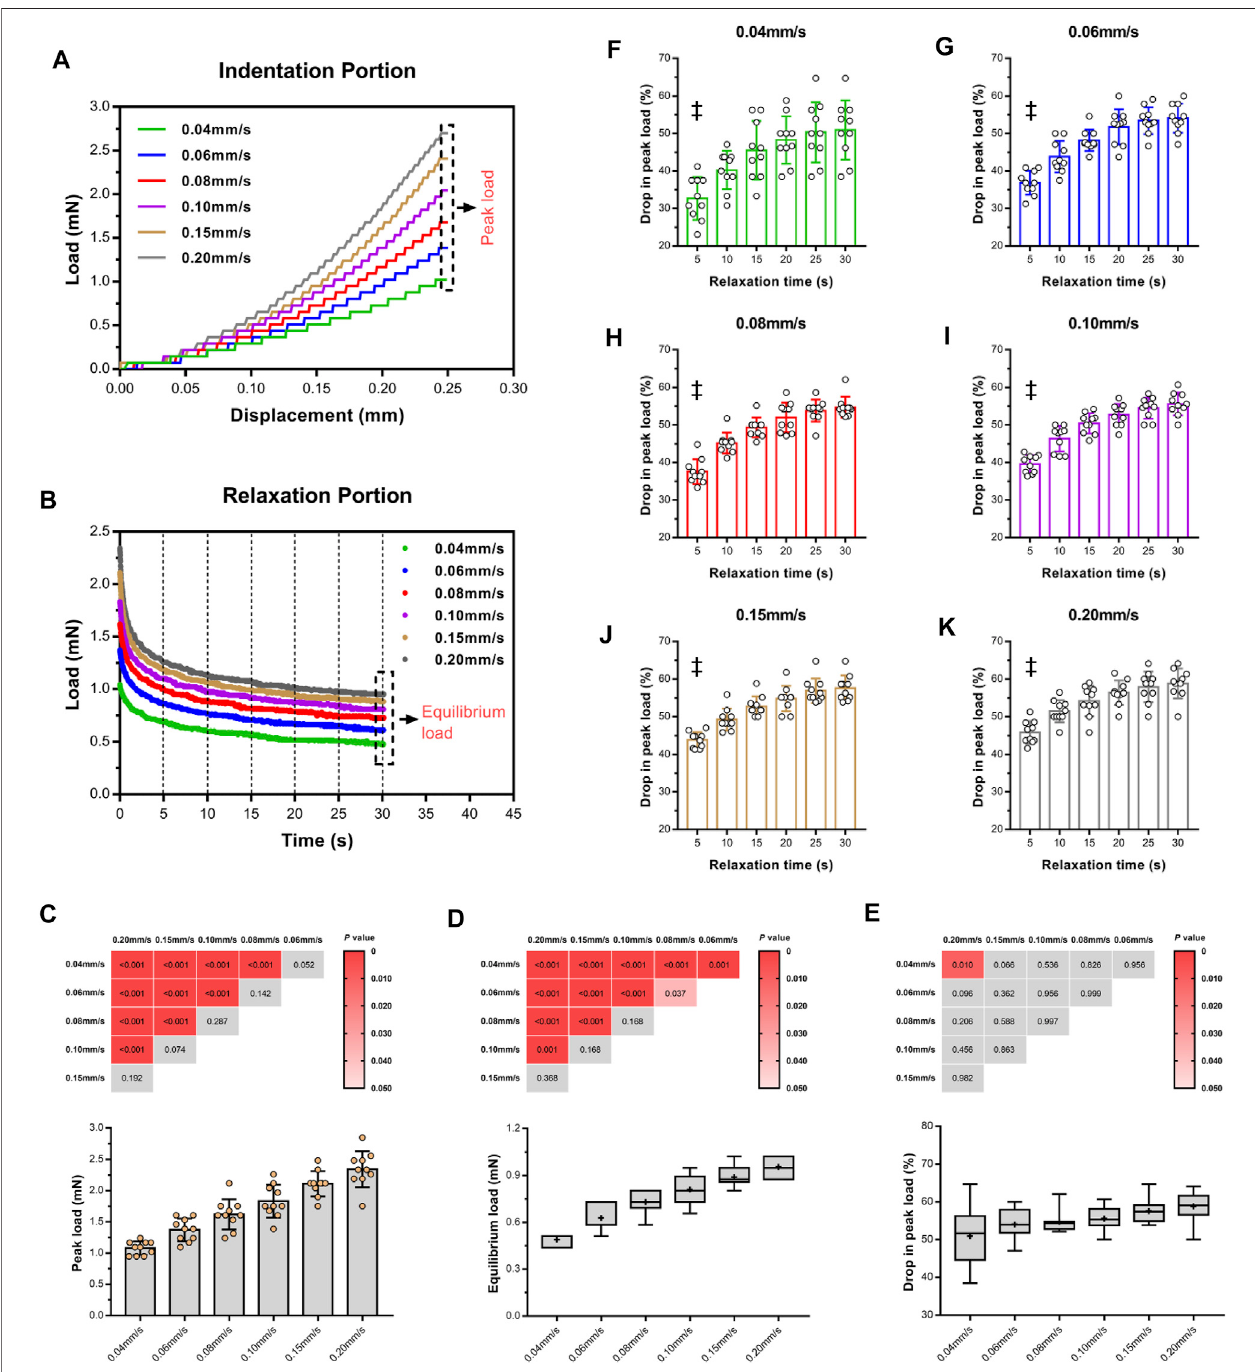
FIGURE 4 | Loading rate sensitivity of ex vivo specimens in indentation portion. Indentation loads increased with increasing velocity (A) . Isochronal plots of relaxation portion for ex vivo specimens at six time points of load – relaxation tests (B) . Average peak loads (C) and equilibrium loads (D) of each test and comparison of difference of two loads (E) among varying velocities, inserted with Turkey ’ s post-hoc tests. Red block indicate p < 0.05, and gray indicated p > 0.05. Average relative dropcompared topeak load (F – K) . ‡ indicate asigni fi cantdifference( p < 0.05)incomparison of5 sand lasttwotime points (25and30 s).Errorbars arestandard (0 – 5 s). After approximately 10 s, the load converged gradually data at various loading rates are shown in Figure 4B . The curve toward its static equilibrium value. The degree of load relaxation showed that most peak load decay occurred in the initial phase present was approximately 50 – 60% of the initial peak load over